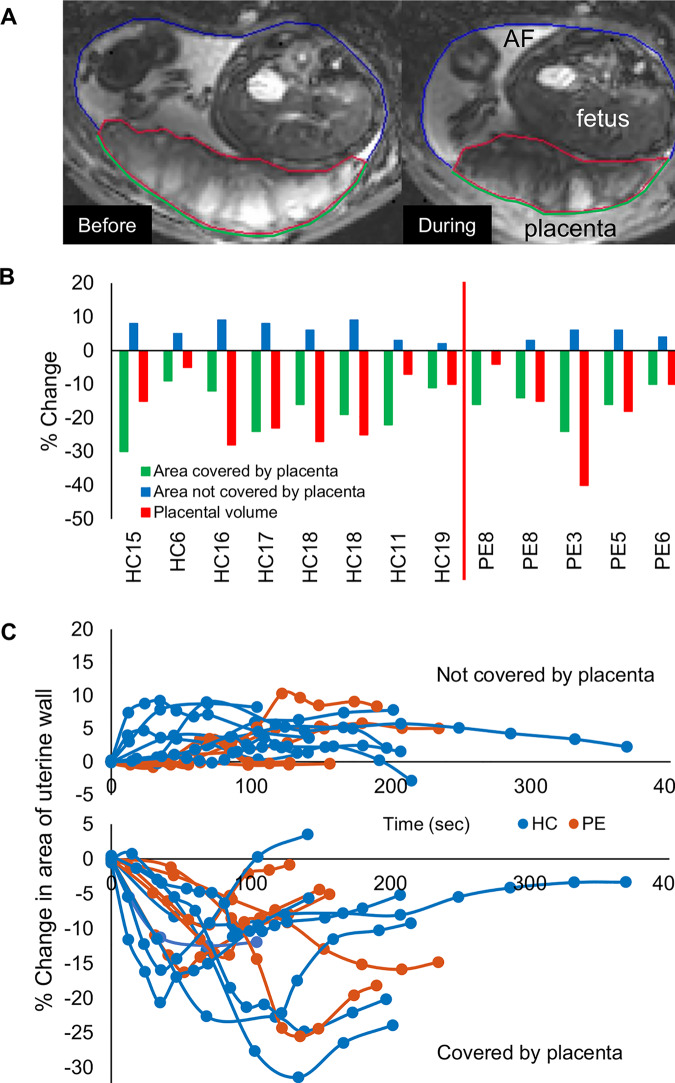
The utero-placental pump.(A) T2*-weighted images of the same placenta (HC17) before and during a contraction, with lines indicating the placental ROI (red) and the parts of the uterine wall that are covered (green) and not covered by placenta (blue). These images show a single slice, but data from slices across the whole uterus were summed to estimate the total volumes and areas involved. (B) Percentage change at maximum contraction of area of uterine wall covered by placenta, area of wall not covered by placenta, and of placental volume (green, blue, and red lines in [A], respectively), in each participant who had contractions during the 10-minute scan. Participants HC18 and PE8 had two contractions in the 10 minutes. Participants are ordered by ascending gestational age at time of scan. (C) Time course of contractions in the same participants, with each line representing the change (%) of the wall not covered by placenta (increased during contraction) and the area of the uterine wall covered by placenta (decreased during contraction). Underlying data plotted in panels B and C are provided in S1 Data. AF, amniotic fluid; HC, healthy control pregnancy; PE, preeclamptic pregnancy; ROI, region of interest.